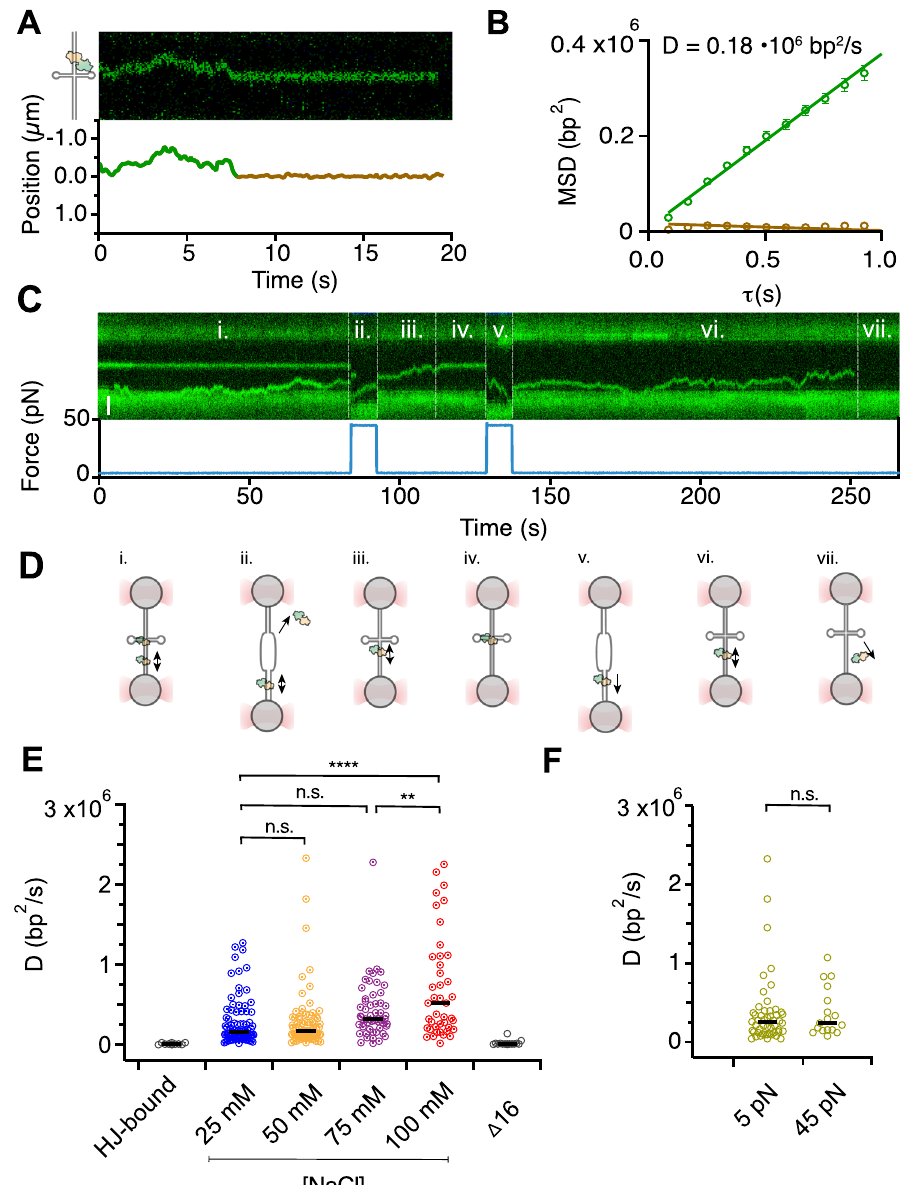
Fig. 3 | Endonuclease I docking is force dependent and its diffusion is salt- dependent. A Top panel: A kymograph showing the endonuclease I (catalytically impaired mutant D55A) that diffuses on dsDNA and docks on a four-way junction. Bottompanel: Thediffusingandstaticsegmentsofthetrajectory(greenandbrown, respectively) resolved by single-particle Gaussian tracking. B Mean-square dis- placement (MSD) plot of the trajectories shown in panel A . Linear fi t of the MSD dependency over intervals 0.2s ≤ τ ≤ 1s yields the diffusion coef fi cient of the diffusing endonuclease I (D=0.021±0.001 μ m 2 s − 1 =0.18·10 6 bp 2 s − 1 , green). The MSD of the static, junction-bound complex does not increase (D=(0.01±0.01)·10 6 bp 2 s − 1 , brown). Error was calculated as standard error of the linear fi t(S.E). C Akymographrecordedat4and45pN(forcemeasurementplotted below). At low tension the endonuclease I is either stably bound to the centrally located four-way junction or diffuses along the duplex DNA. At high tension, the junction-bound complex dissociates or diffuses away due to the unfolding of junction. D A cartoon representation of the optically trapped DNA with the endo- nuclease I (D55A) during the course of the experiment presented in panel C. E Distribution of the diffusion coef fi cients of endonuclease I at different ionic strengths in comparison with static molecules. Black circles: Endonuclease I com- plexes that are bound to the four-way junction do not diffuse and the calculated apparent diffusion rates re fl ect the detection limit of the Gaussian tracking (D HJ =